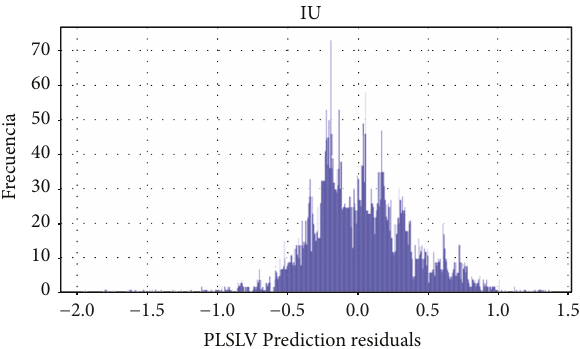
Figure 3: Residue density within the sample and outside the